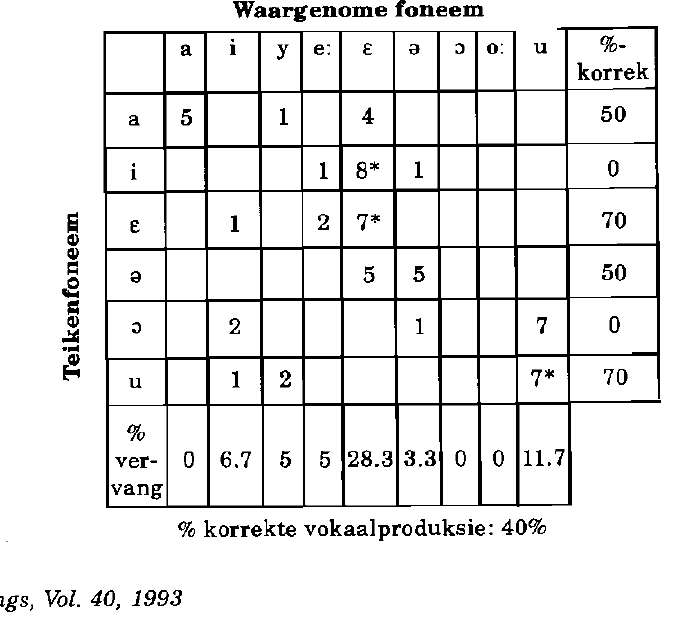
Tabel 9. Vokaalbeoordelings van Spreker